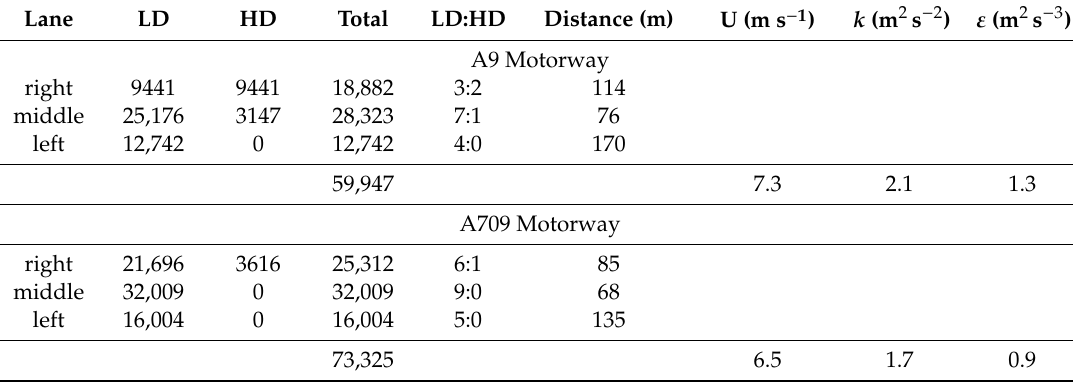
Table 1. Mean daily tra ffi c density used to calculate fleet momentum and turbulence. LD and HD are daily numbers of light duty and heavy duty vehicles with their respective proportions used in the model (LD:HD). Distance corresponds to the distance between two consecutives vehicles. Note that only the numbers in bold characters are derived from tra ffi c data (see text for explanation) in the north–south direction. We assumed that these values are the same for tra ffi c in the opposite direction. U, k, and ε are the average velocity deficit, average turbulent kinetic energy and average turbulent dissipation rate, respectively, derived from the